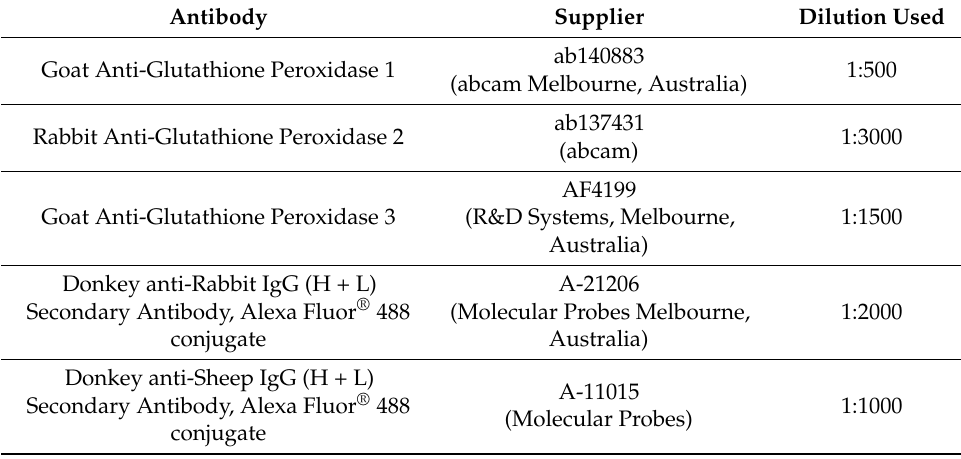
Table 2. Primary and secondary antibodies used for Western blot analysis. Antibody